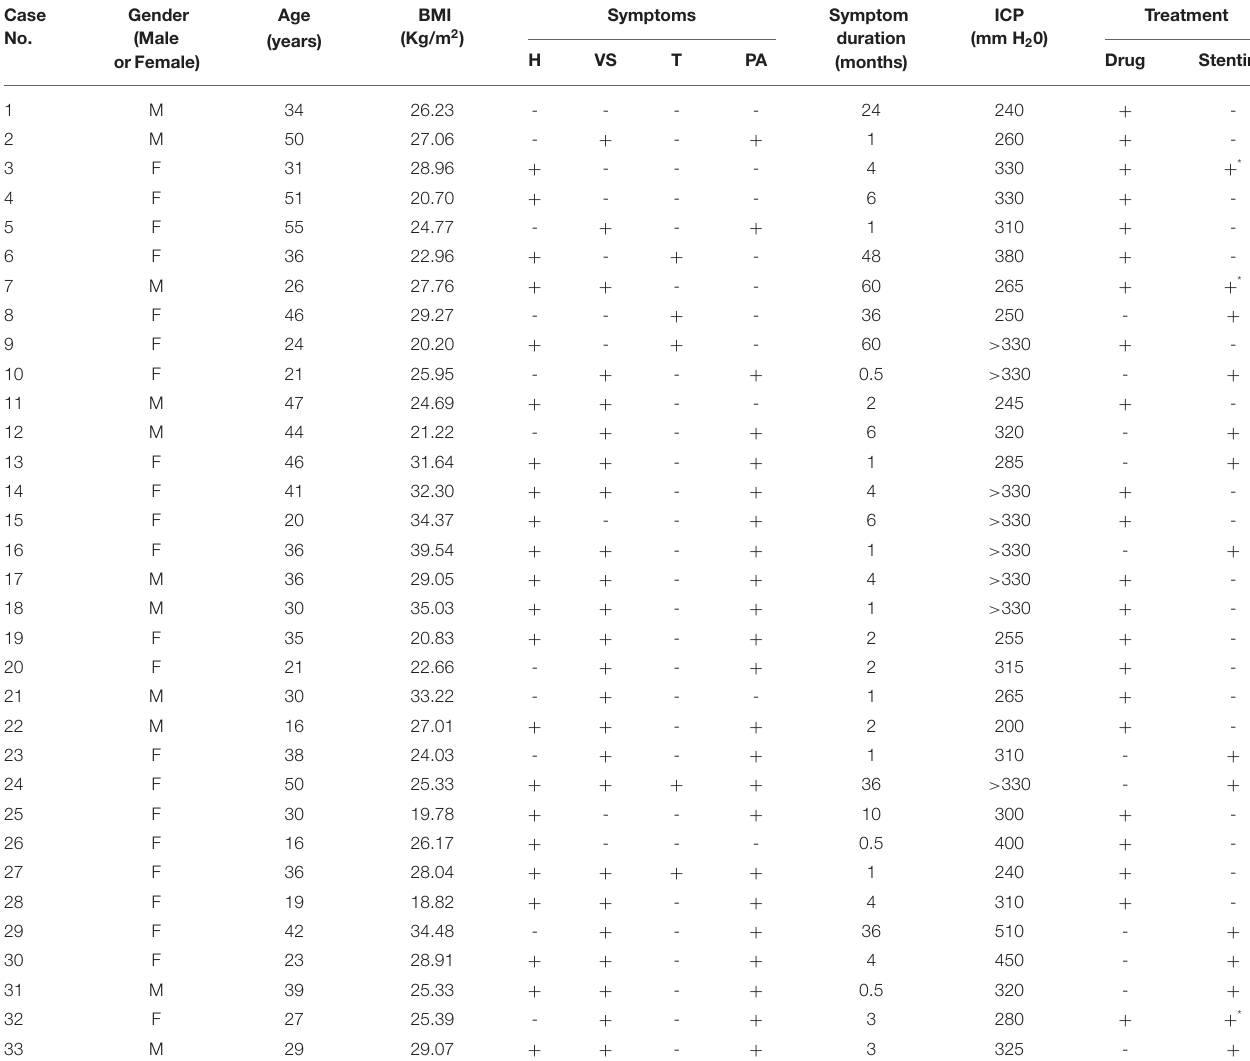
TABLE 2 | Clinical features of 33 enrolled patients with IIH. Case